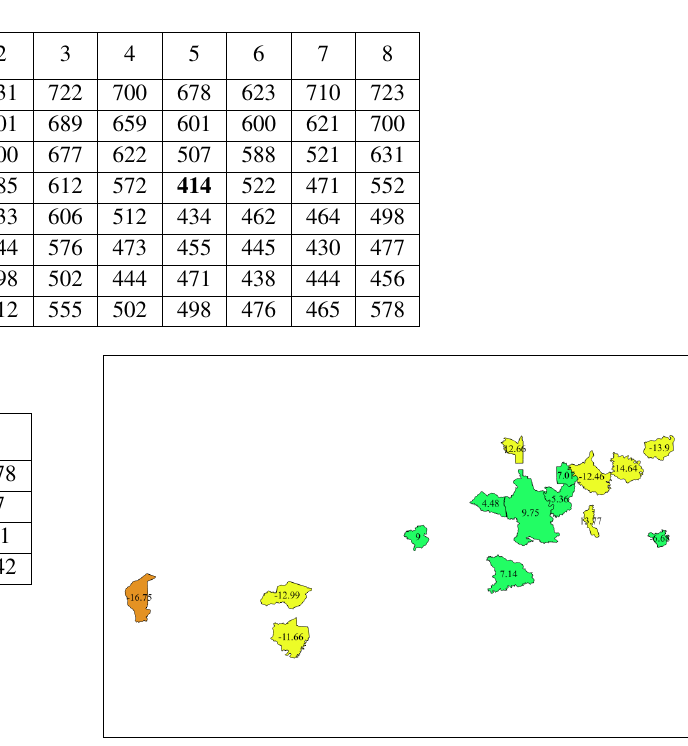
Table 3. Performance of RFR in terms of RMSE